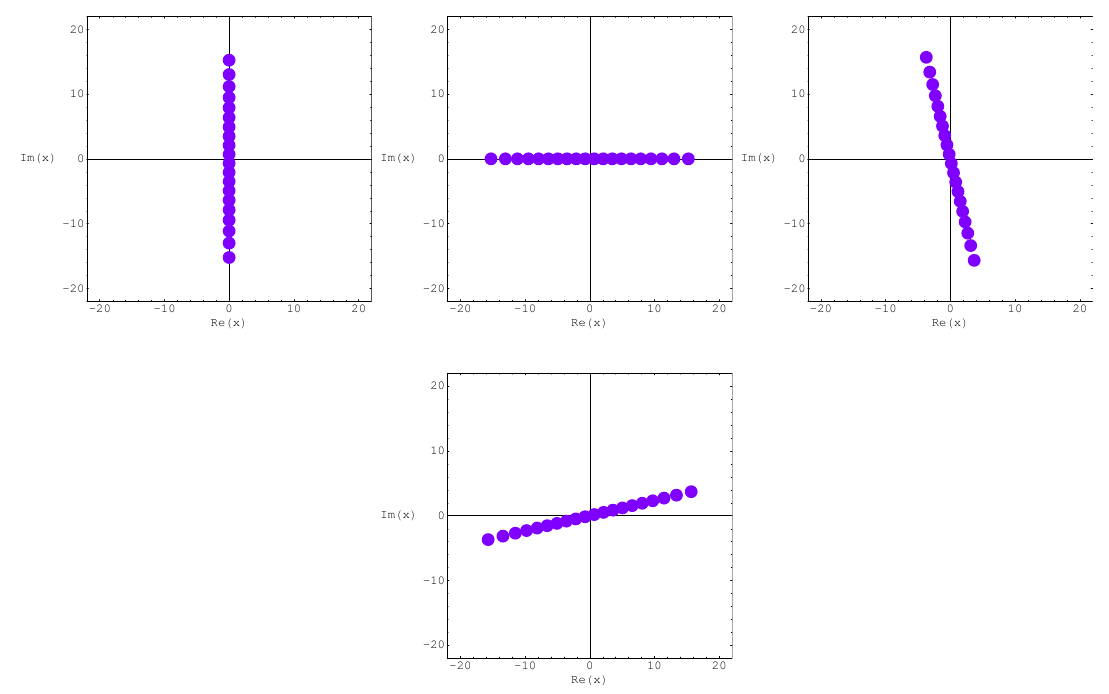
Figure 2. Zeros of H n ( x , y ) .